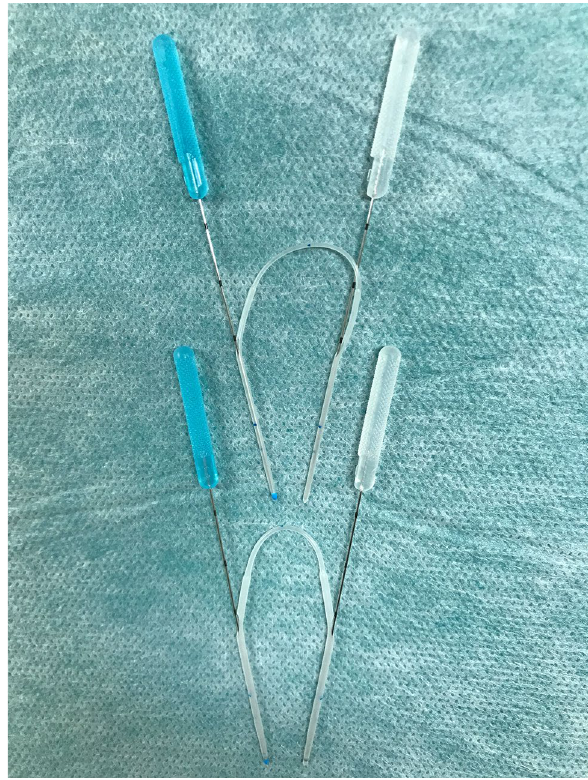
Figure 2. Two types of different-thicknesses NSTs. Shown at the top is a 1.0-mm-diameter tube, and the bottom is a 1.5-mm-diameter tube. The NST is designed with a metal guide probe concealed in the lumen of the tube. Abbreviation: NST, Nunchaku-style